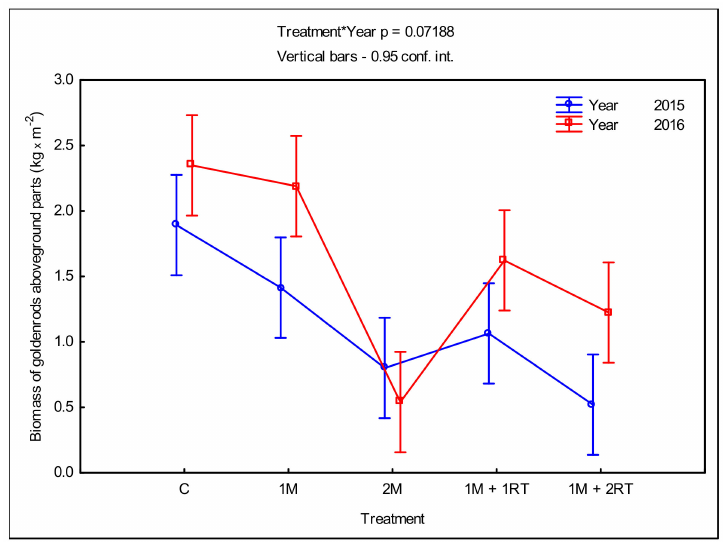
Figure 8. Mean fresh mass of the aboveground parts of goldenrods per 1 m 2 , depending on the type of mechanical treatment. The following symbols denote the research treatments: C: control; 1M: one-time mowing; 2M: two-time mowing; 1M + 1RT: one-time mowing with one-time rotary tilling; 1M + 2RT: one-time mowing with two-times rotary tilling.